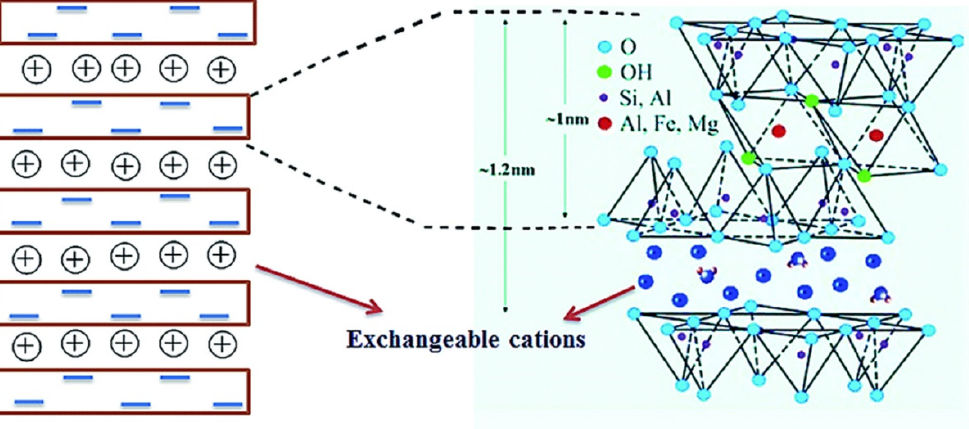
Figure 1. Nanometric ( left ) and atomic ( right ) structure of layered phyllosilicates from Ref. [7].